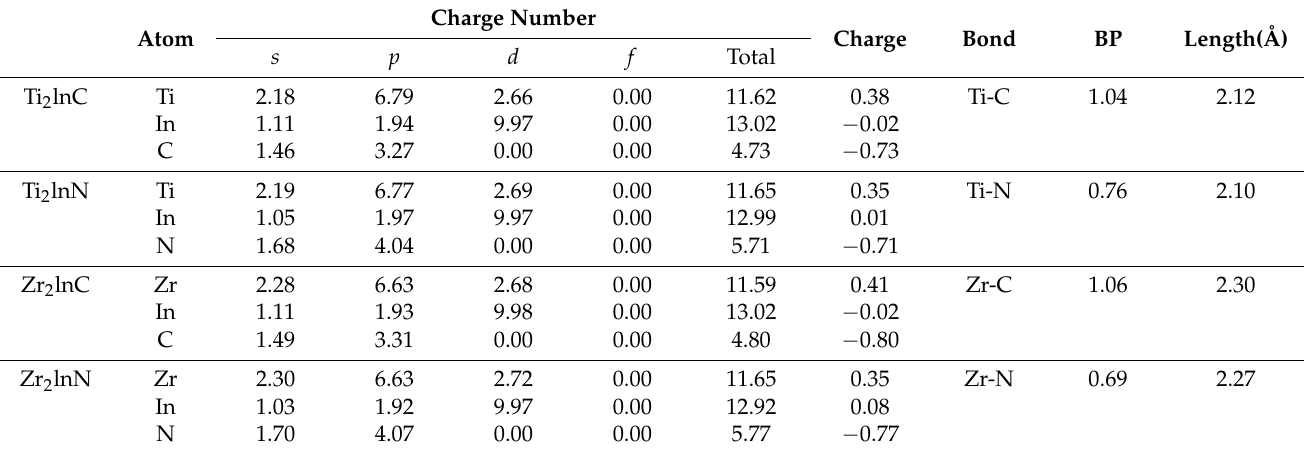
Table 9. Calculated Mulliken charge and bond population (BP) analysis of M 2 InX (M = Ti, Zr and X = C, N) MAX